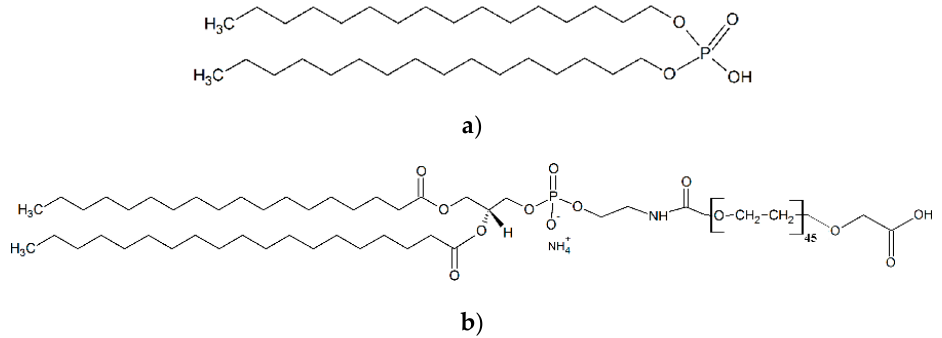
Figure 1. Molecular structure of ligands used for superparamagnetic iron oxide nanoparticles (SPIONs) functionalization. ( a ) dihexadecyl phosphate (DHP); ( b ) 1,2-distearoyl-sn-glycero-3-phosphoethanolamine-